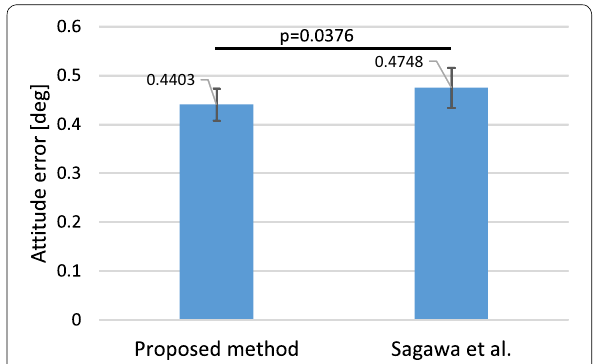
Fig. 10 Results of attitude estimation experiments using real IMU data. Error bars indicate standard